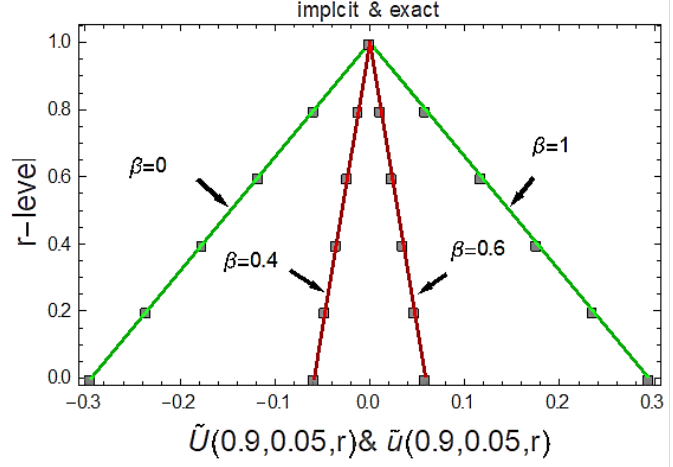
0.05 and 𝑥 = 0.9 for all 𝑟, 𝛽 ∈ [0,1] .